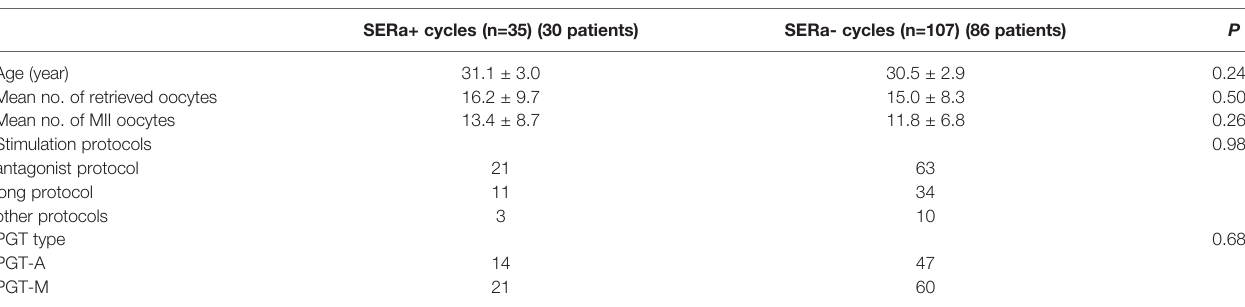
TABLE 1 | Baseline